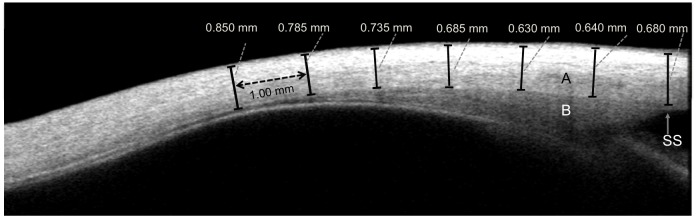
OCT image of the temporal sclera (A). Ciliary muscle (B); Scleral spur (SS).Calipers (in black) shown for scleral thickness measurements for 6 mm from the SS at 1 mm intervals (in dotted black).